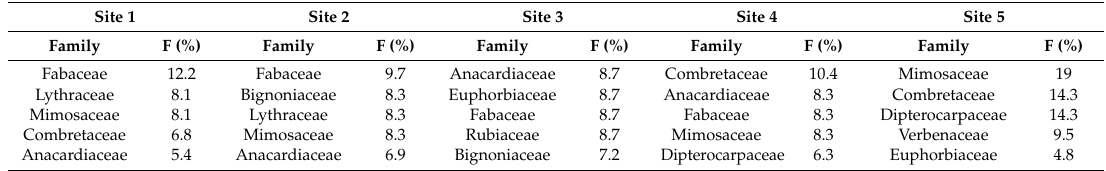
Table 2. Frequency of the five most commonly occurring families at five study sites.